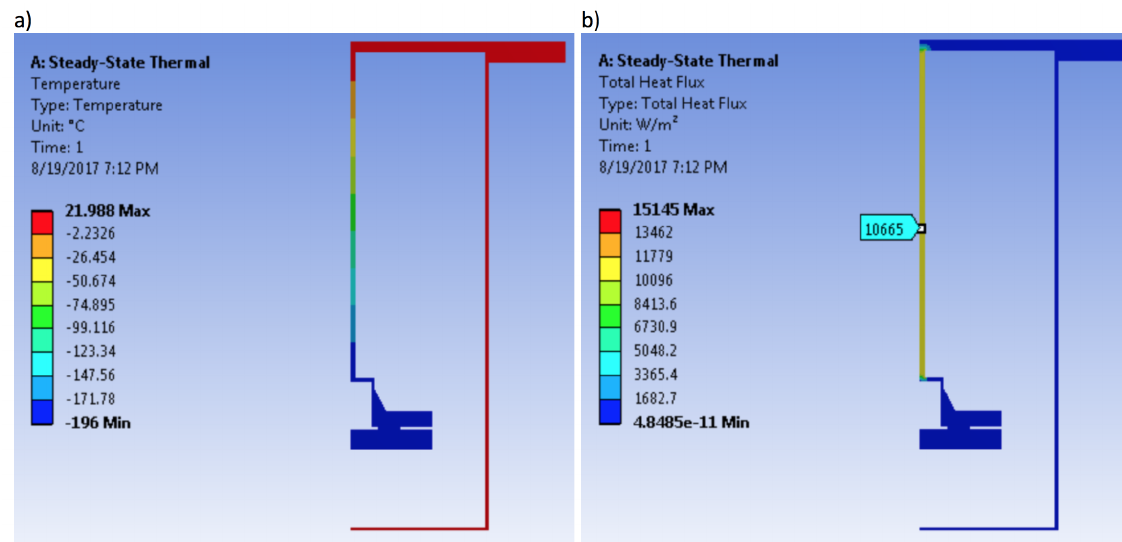
Figure 5: Results of the thermal analysis, a) temperature distribution, b) heat flux